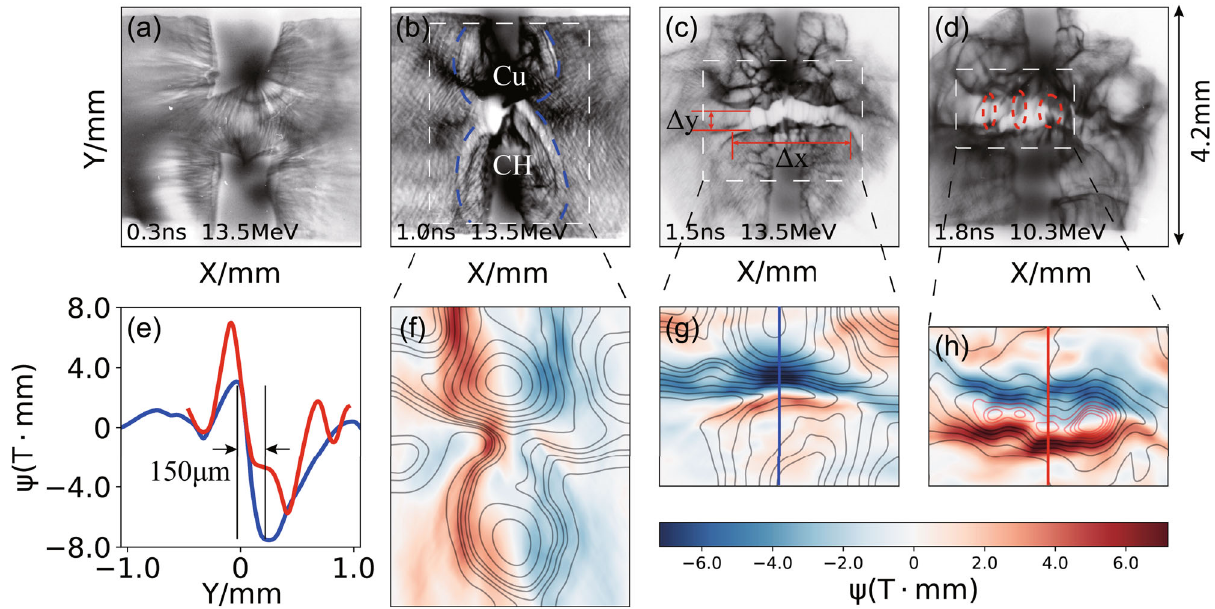
Fig. 3 Experimental results of hybrid collisional-collisionless magnetic reconnection. a – d are the proton radiography results of magnetic fi eld topologies at time t = 0.3, 1.0, 1.5 and 1.8 ns respectively, where the upper half is for collisional Cu plasma and the lower is for collisionless CH. The higher the grayscale represents the higher the proton doses, and all images are rescaled to the realistic length through dividing by the radiography geometric magni fi cation M ~ 6.0, see Methods. f – h are the reconstructed path-integrated magnetic fi elds ψ , corresponding to the dashed-box region in ( b - d ) respectively, where the color map in ( f ) represents B y component and those in ( g ) and ( h ) represent B x components. The contour lines in ( f - h ) represent the corresponding vector potential A z . ( e ) shows the pro fi les of ψ in ( g ) (blue line) and ( h ) (red line) along